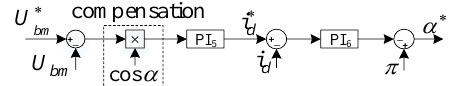
Figure 7. Proposed power based voltage ( P - V ) control for LCR.